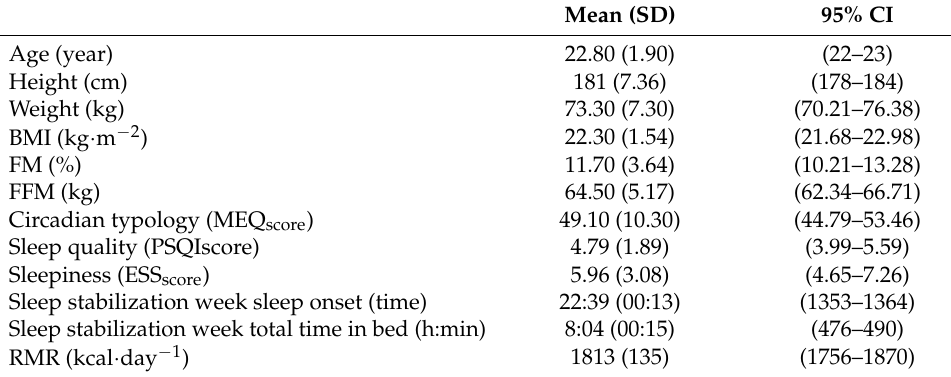
Table 1. Characteristics of study